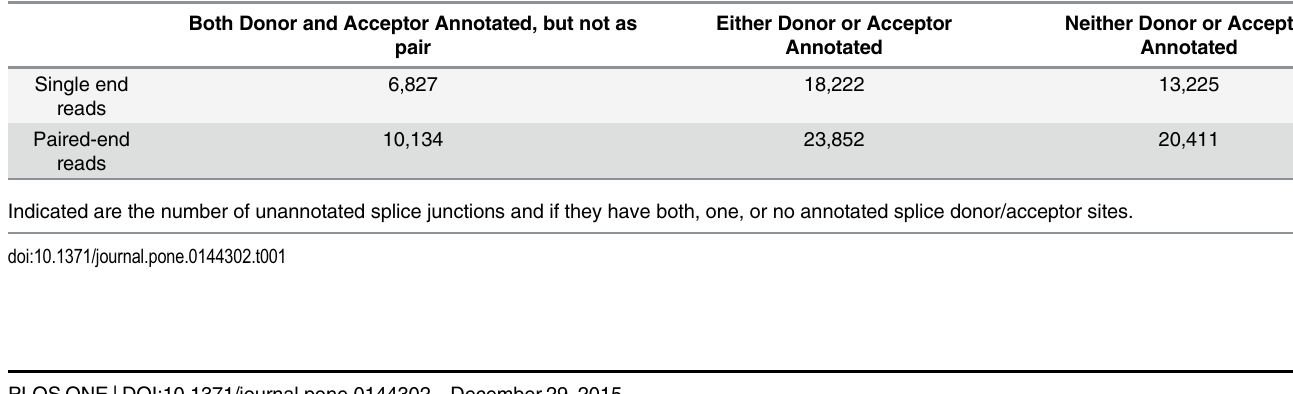
Neither Donor or Acceptor Annotated